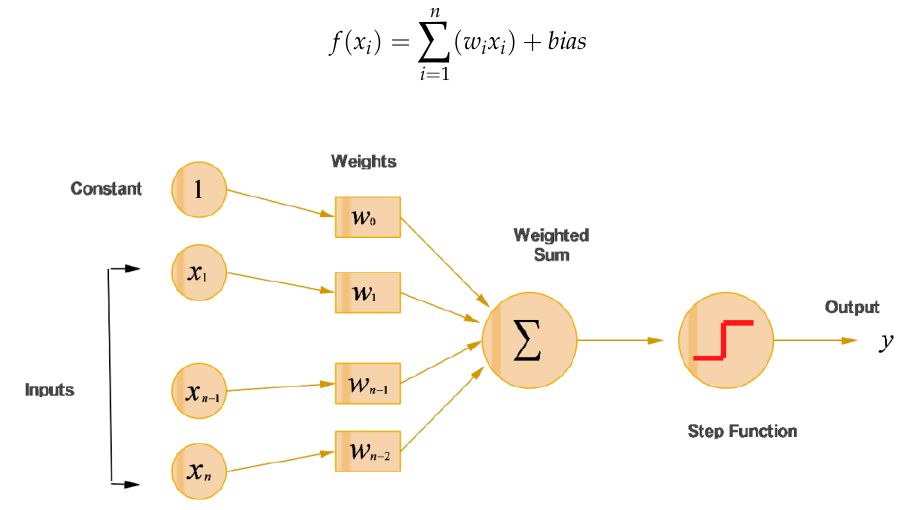
Figure 3. Schematic algorithm of multi-layer perceptron (MLP).